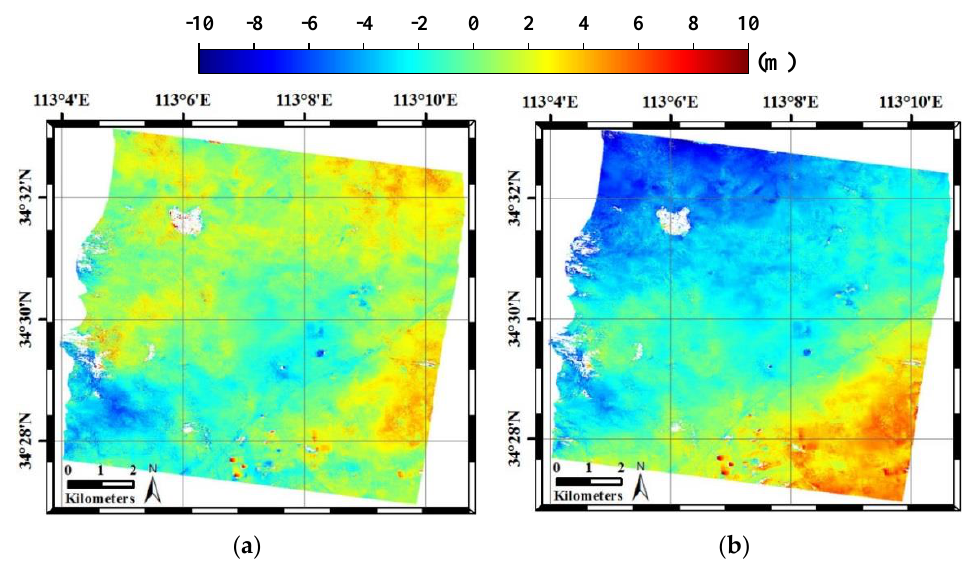
Figure 14. Distribution maps of evaluation difference between the 1:2000-scale DEM and the obtained DEM with GCPs ( a ) and without GCPs ( b ).